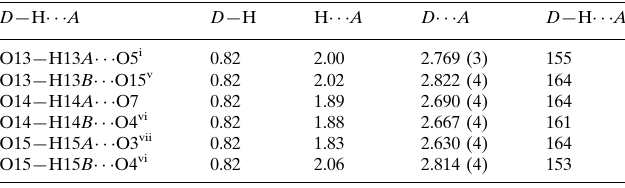
Hydrogen-bond geometry (A˚ , (cid:4)